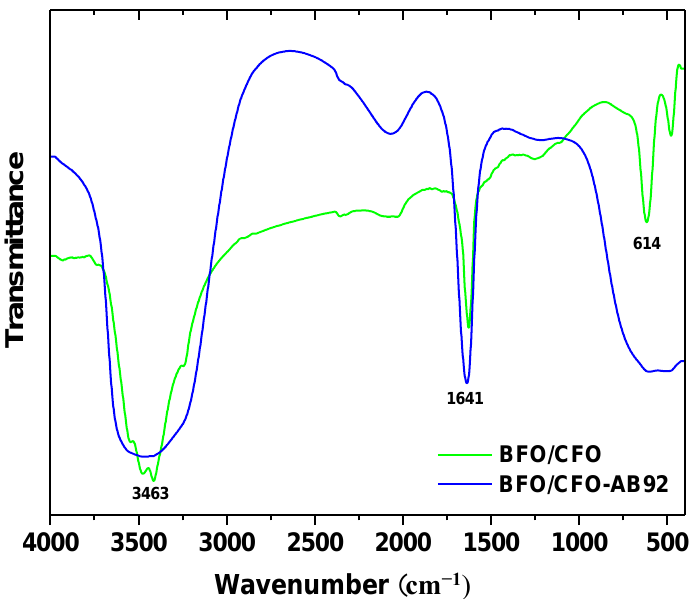
Figure 6. FTIR spectra of BFO/CFO@PEG nanocomposites before and after the adsorption experiment. Thermal stability of BFO/CFO and PEG has been analyzed using TGA (Figure 7). TGA was performed in the temperature range of 25–700 ◦ C to further confirm the existence of PEG on the surface of BFO/CFO nanoparticles and quantify the proportion of organic and inorganic phases. Pure PEG has started to combust at ∼ 330 ◦ C and completely com- busted at ~430 ◦ C. Evidently, the combustion of PEG coated BFO/CFO nanoparticles starts earlier than the decomposition of pure PEG and continues up to 700 ◦ C. The earlier part of combustion curve is due to the evaporation of organic solvents and water. The second part (between 220 and 430 ◦ C) corresponds to decomposition of PEG and BFO/CFO compos- ites into oxides. The temperature at which the decomposition of PEG coated BFO/CFO nanoparticles starts is lower than that of PEG alone, which indicates the catalytic effect of BFO/CFO nanoparticles on the degradation of the PEG. Nanocomposites show a major weight loss of ~20% over the temperature range of 25–700 ◦ C due to the decomposition and combustion of PEG. This implies that nanocomposites have approximately 80% inorganic phase as BFO/CFO